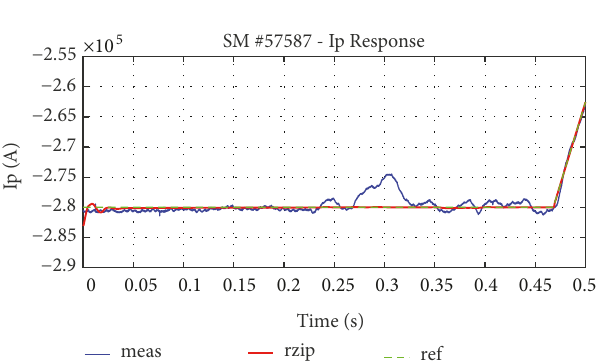
Figure 9: Sliding mode response (Shot #49626).